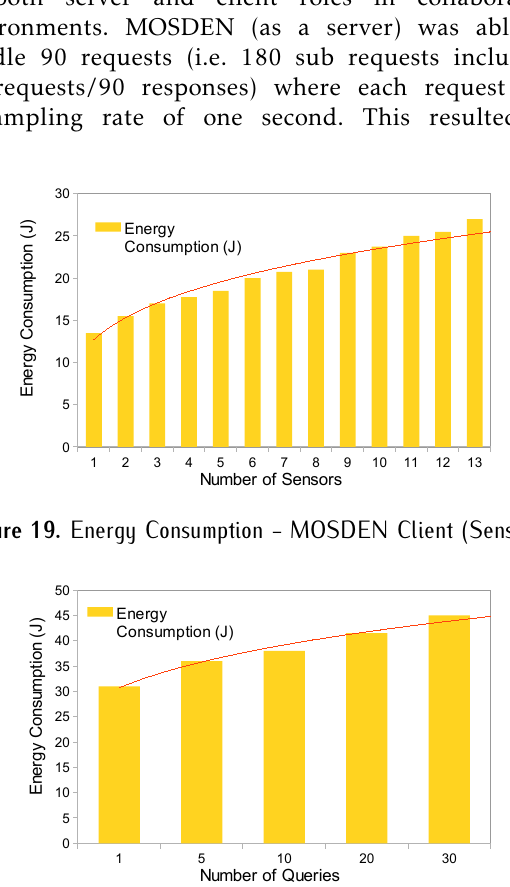
a MOSDEN server (running on a mobile device) processing 5400 data points (90 requests * 60